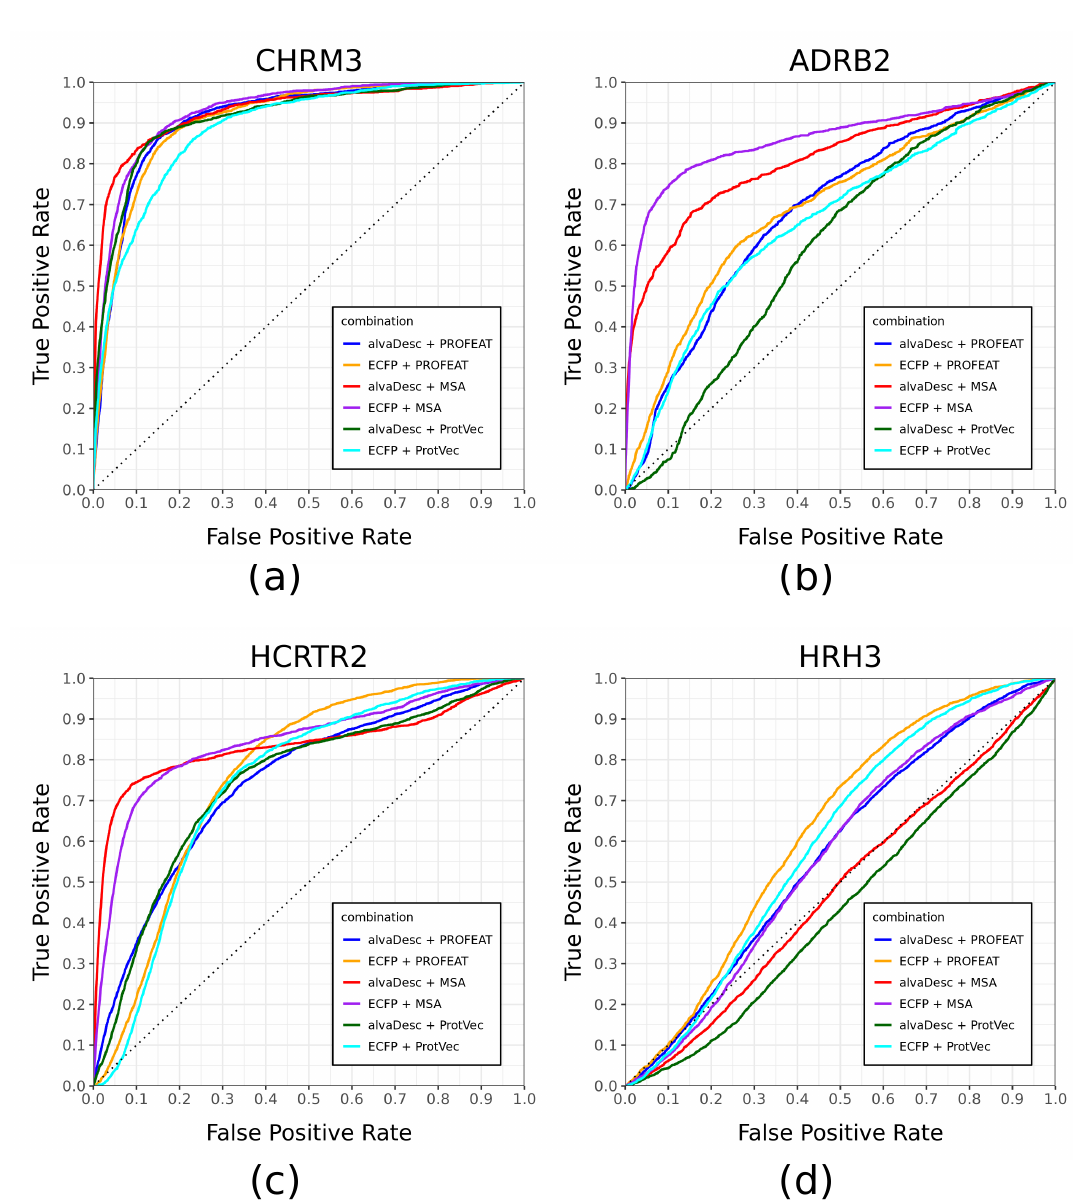
Figure 5. ROC curves of four representative GPCRs generated after screening of designated compound dataset using virtual orphan GPCR models. Characteristic results are shown for four selected GPCRs. Red, blue, and green lines indicate the combination of alvaDesc with MSA, PROFEAT and ProtVec, respectively. Purple, orange, and light blue lines indicate the combination of ECFP with MSA, PROFEAT, and ProtVec, respectively. ( a ) CHRM3; ( b ) ADRB2; ( c ) HRH3; ( d )